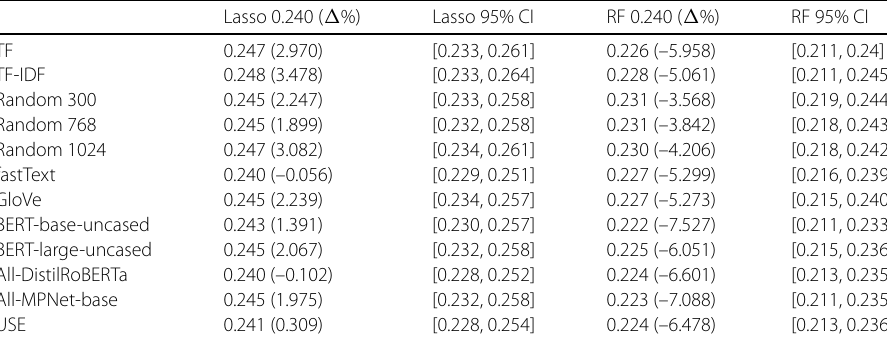
Table 5 Results of the Predictive Validity Analysis. MAE is the mean absolute error between predicted and observed scores. (cid:3) % in the parentheses indicates the percentage change in MAE in comparison to the baseline MAE: 0.240. 95% CI refers to the 95% confidence interval around MAE Lasso 0.240 ( (cid:3) %)